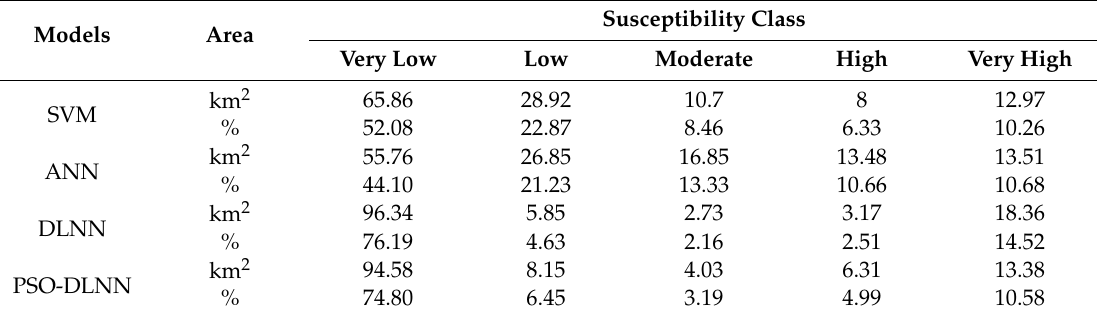
Table 4. Areas of gully erosion susceptibility